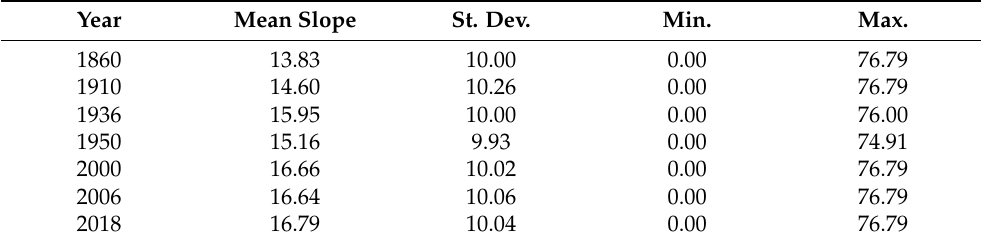
Table 6. Descriptive statistics related to slope (degrees) for each year of